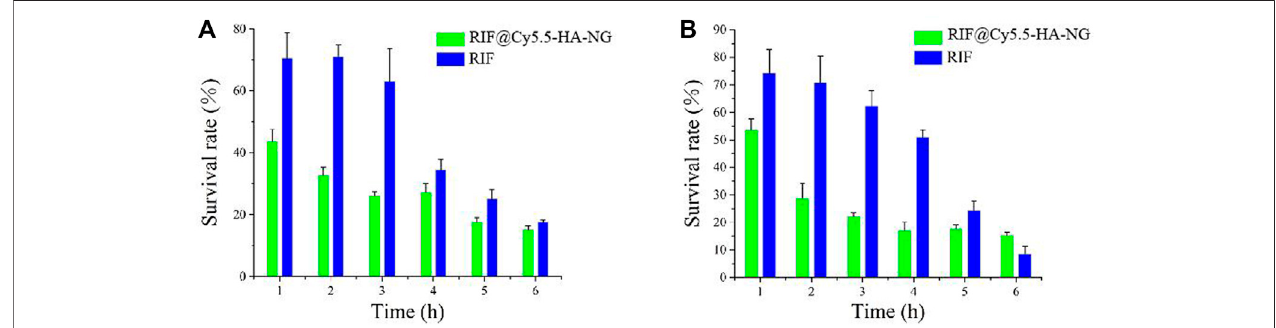
FIGURE 4 | Evaluation of the antibacterial activity and toxicity of the RIF@Cy5.5-HA-NG. (A) Fluorescence imaging of mice at 0, 6, 12, and 24 h after injection. (B) Fluorescence imaging of major organs (liver, spleen, lung, and kidney) collected from animals at 0, 6, 12, and 24 h after injection. (C) Tissue damage analysis of different important organs in mice after intravenous injection of RIF@HA-NG at different times.